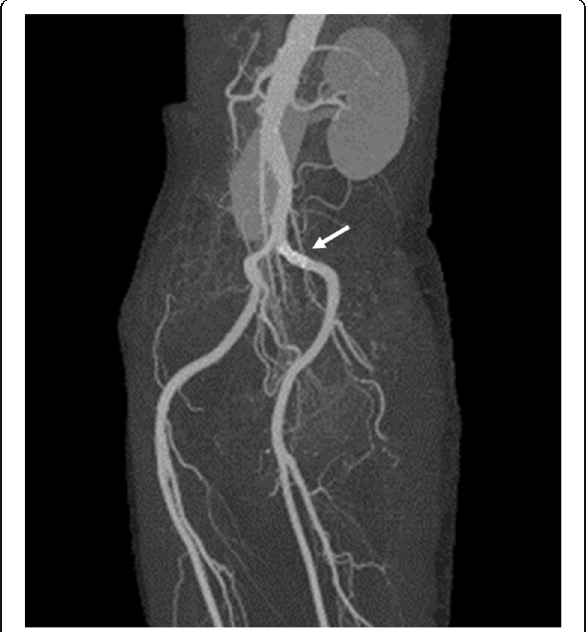
Fig. 2 On contrast-enhanced computed tomography the stent (arrow) implanted in the left common iliac artery showed good